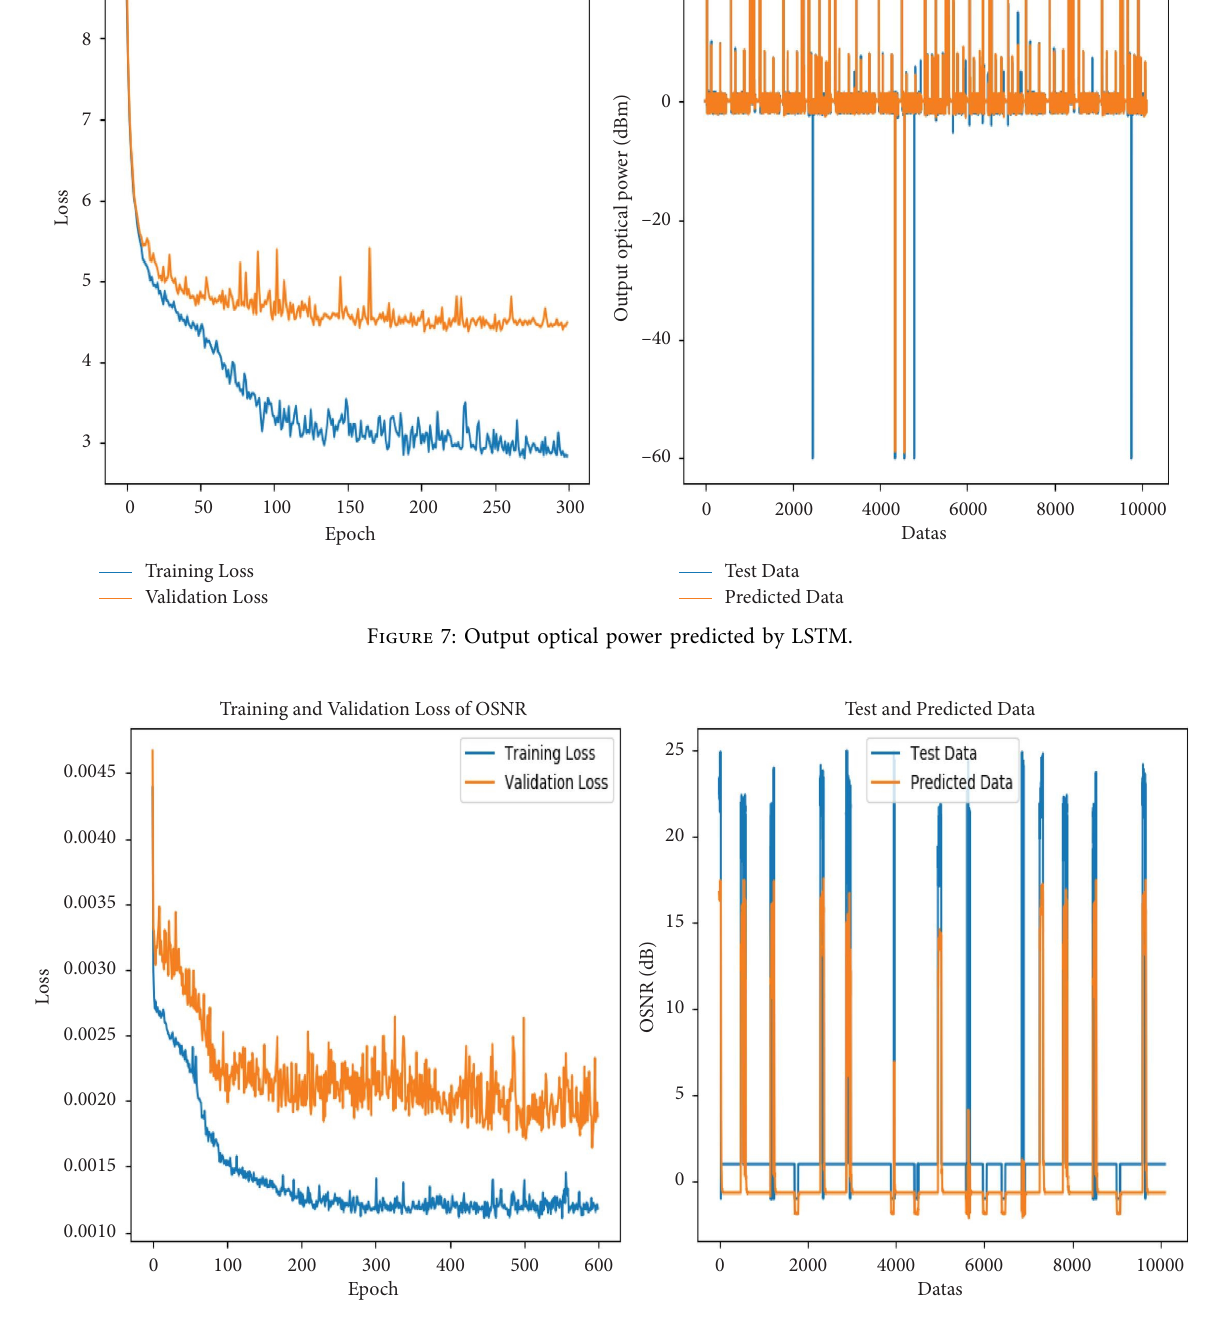
Figure 8: OSNR predicted by